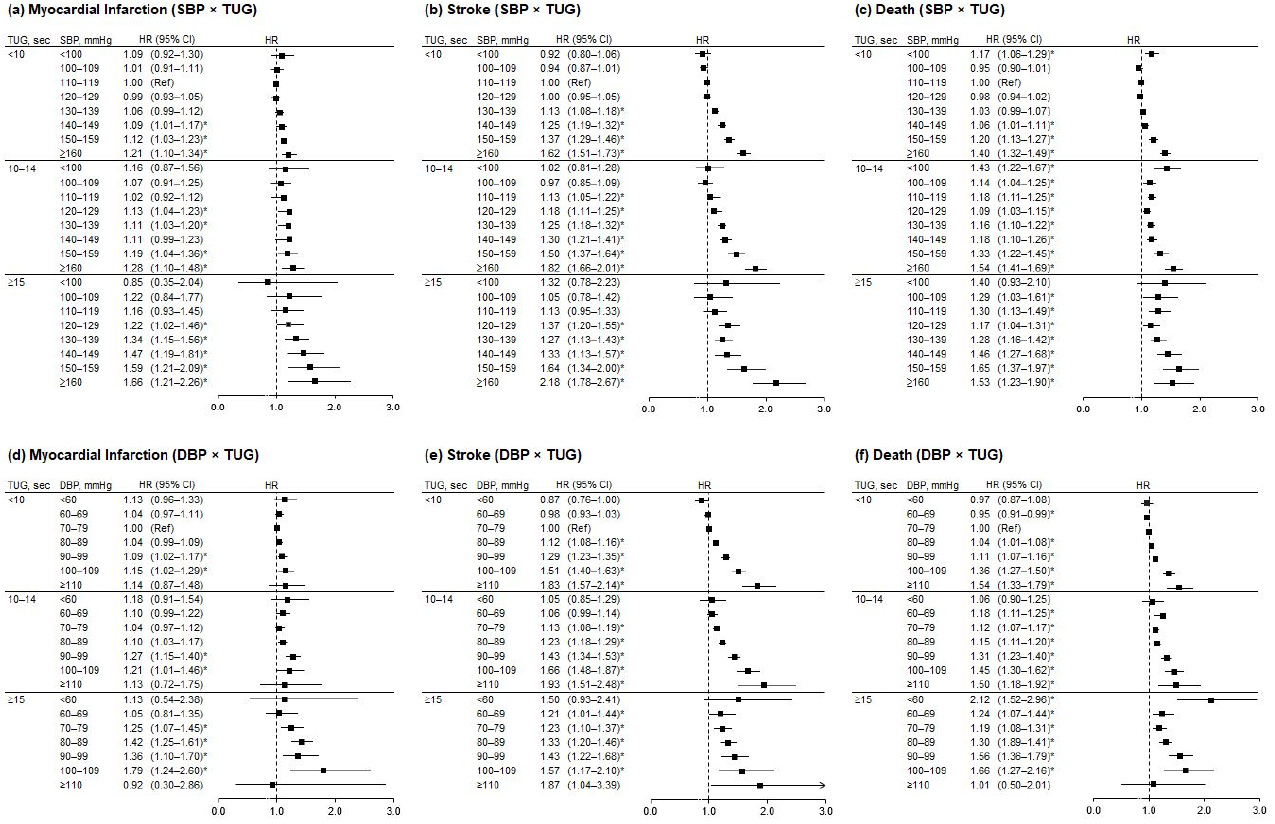
Figure 2. Hazard ratios for incidence of myocardial infarction, stroke, and death according to blood pressure, stratified by timed-up-and-go (TUG) test performance. Hazard ratios were adjusted for sex, BMI, smoking, hemoglobin level, alcohol drinking, regular exercise, income, antihypertensive drug use, diabetes, chronic kidney disease, and chronic pulmonary obstructive disease. Error bars indicate 95% confidence intervals. Asterisks indicate statistically significant values. TUG, timed-up-and-go test; SBP, systolic blood pressure; DBP, diastolic blood pressure; HR, hazard ratio; CI, confidence interval; Ref, reference.